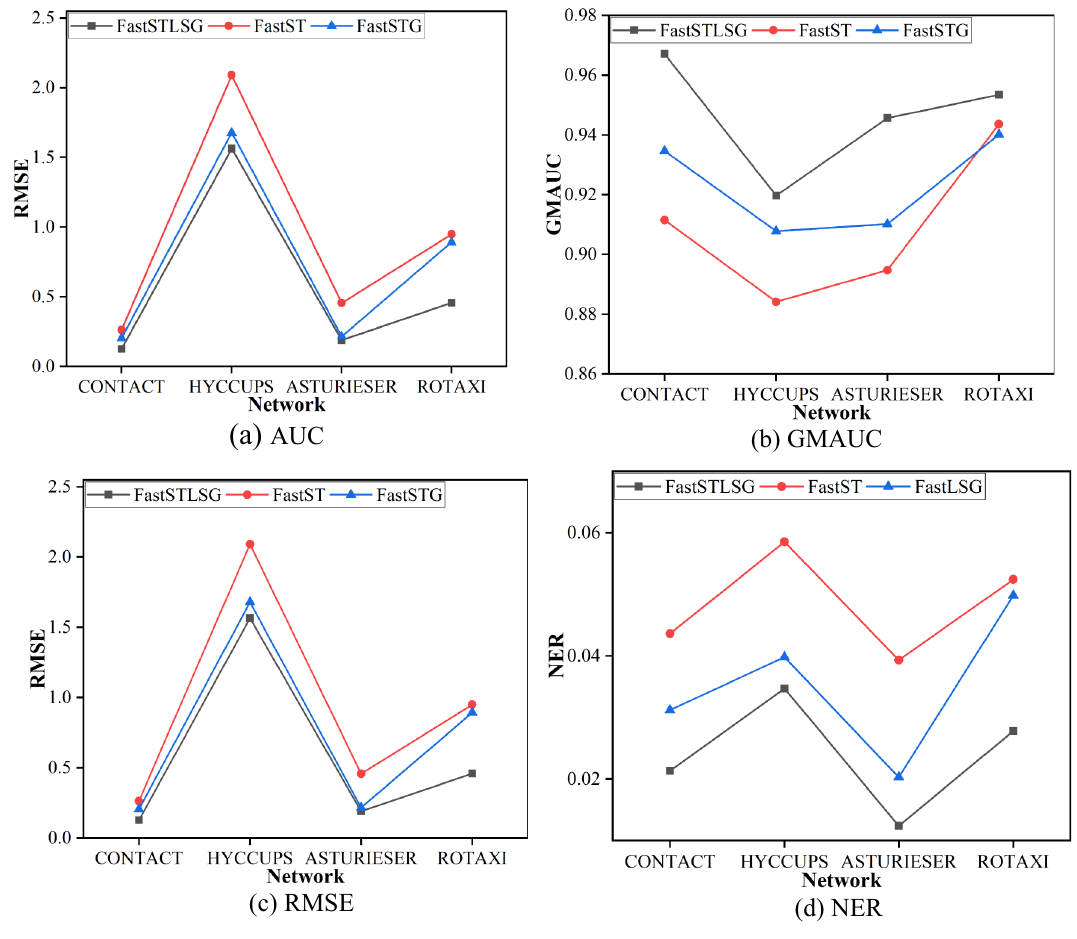
Figure 6. Performances on different MANETs for FastSTLSG, FastST and FastG.